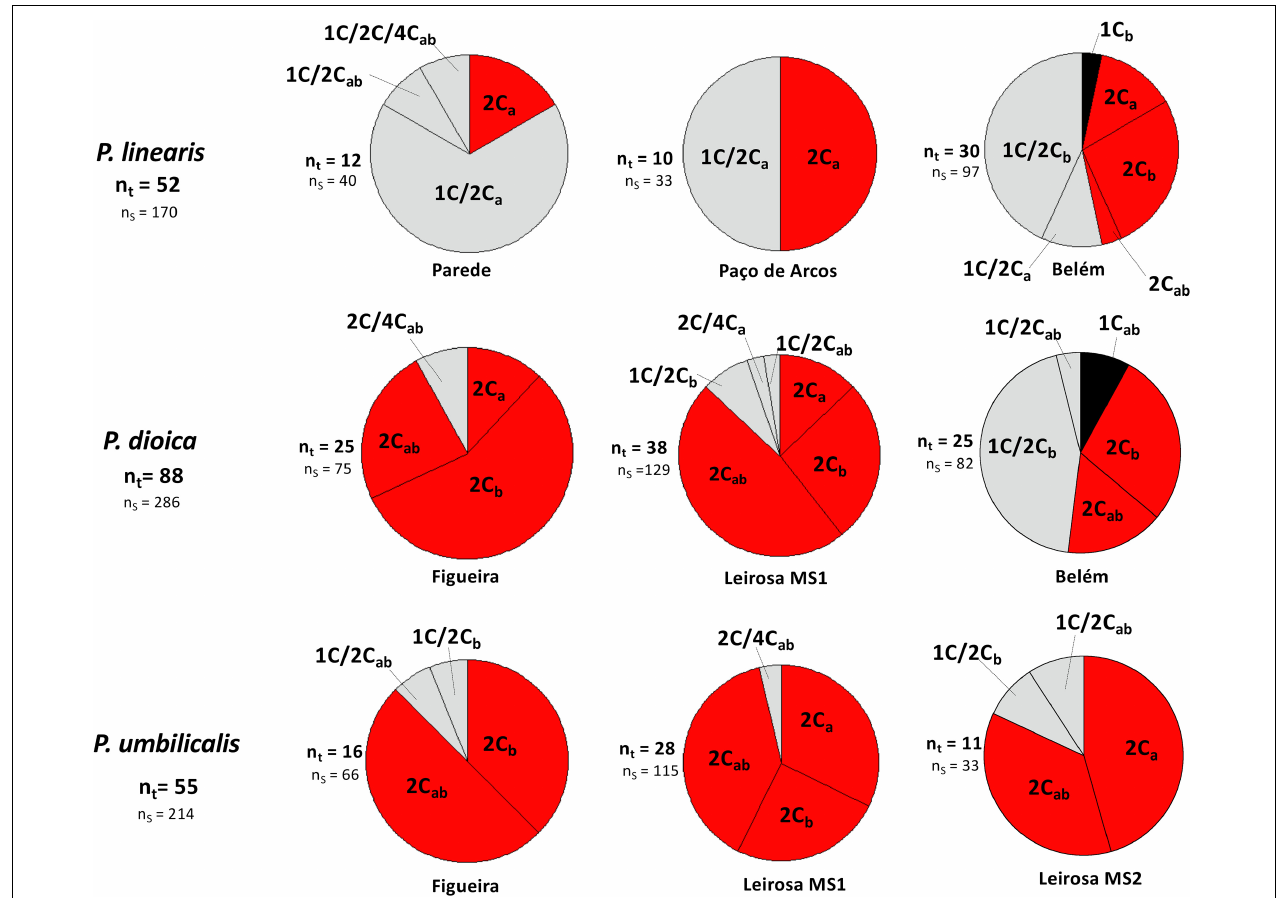
FIGURE 5 | Distributional patterns of cytotypes based in genome sizes of vegetative thalli for each Porphyra species by localities. n t , Total number of blades per species and per locality; n s , Total number of thallus sections analyzed per locality and per